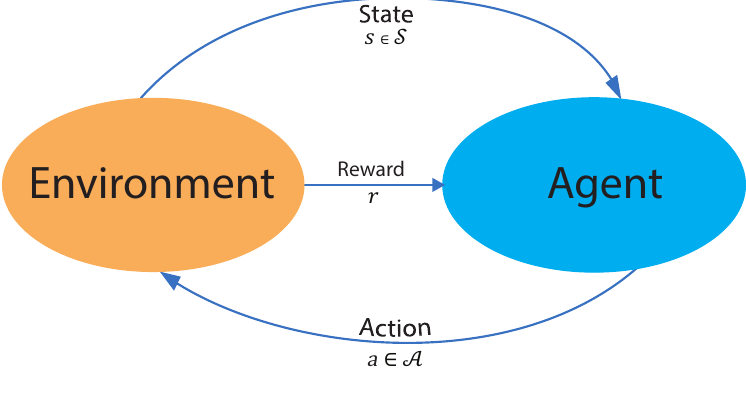
Figure 1. Reinforcement Learning